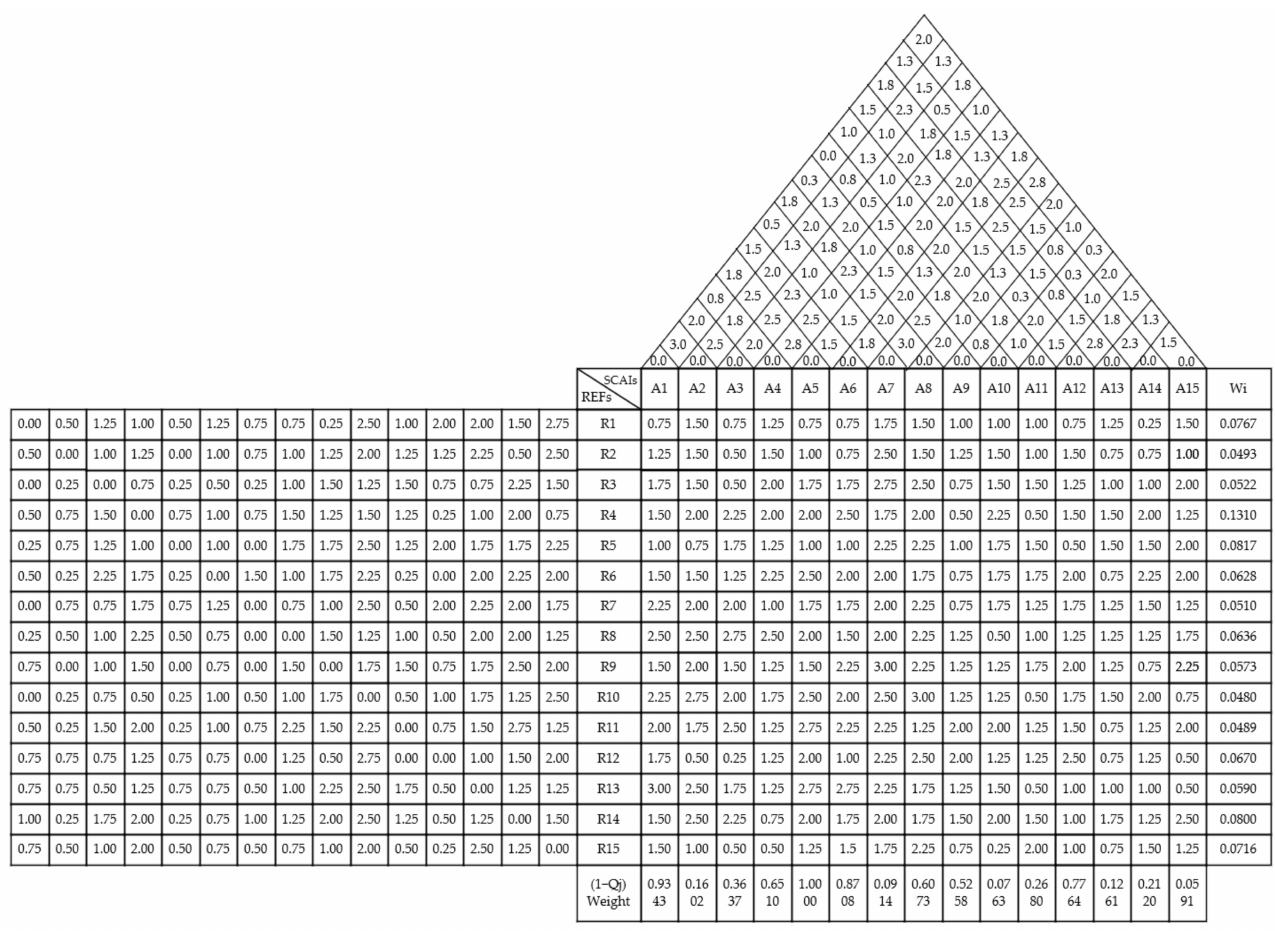
Figure 3. First HoQ between REFs and SCAIs. Table 15. Fuzzy Delphi method (FDM) results of key